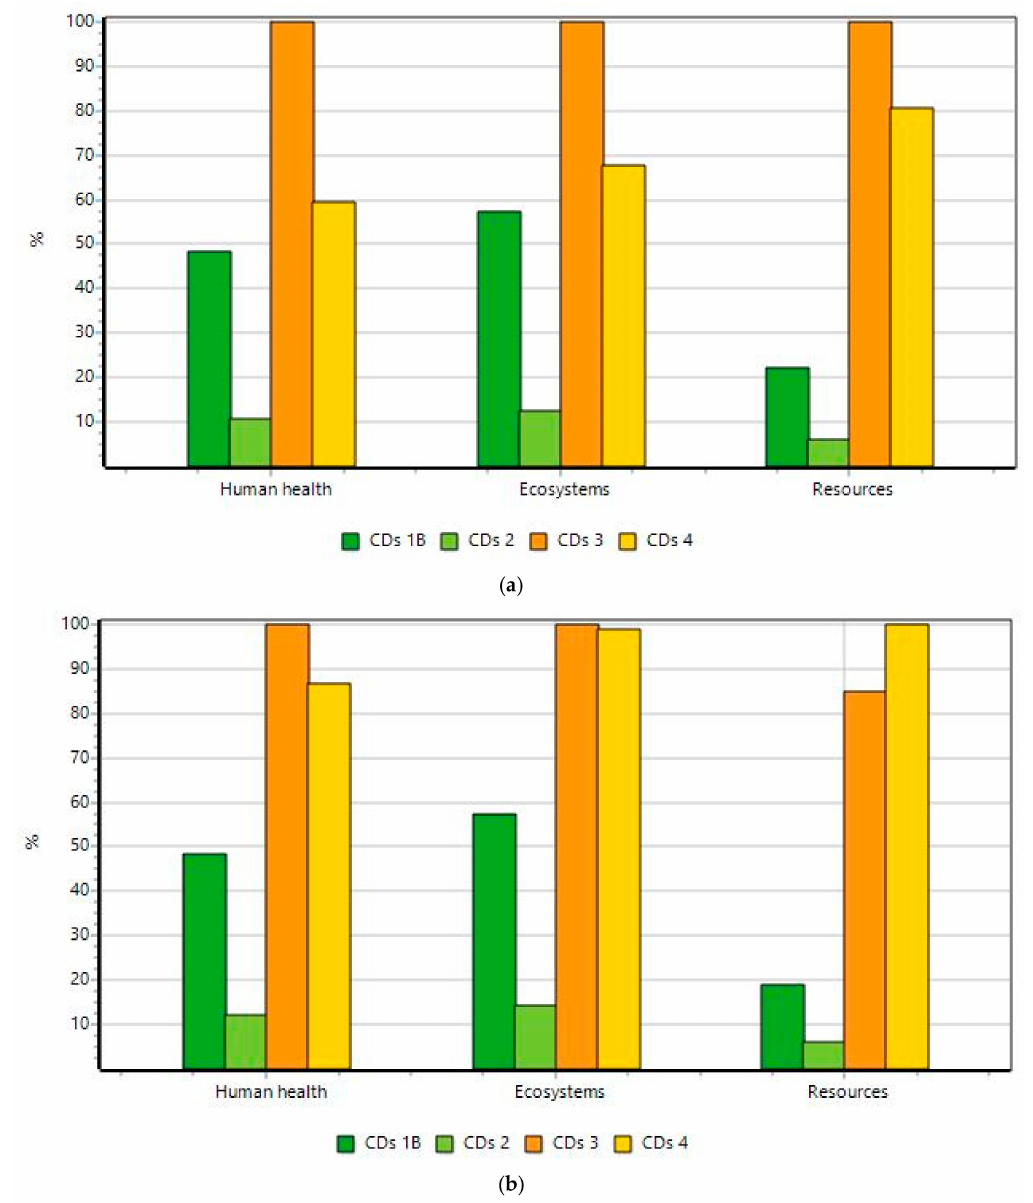
Figure 4. Comparative damage assessment of CDs 1B to 4 ( a ) using weight-based functional unit analysis for 1 kg of CDs produced and ( b ) using QY FL –based functional unit